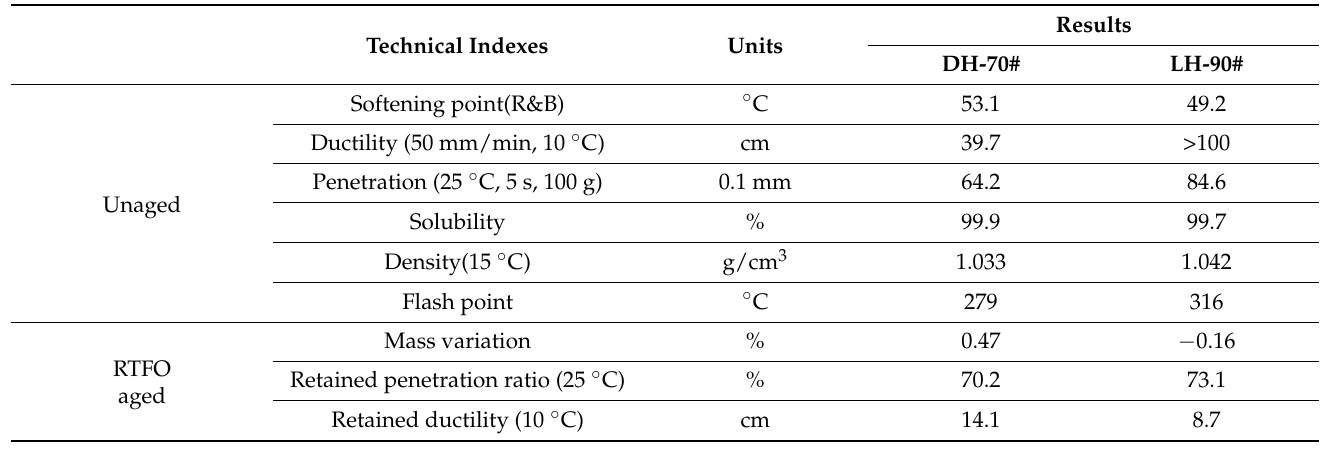
Table 1. Technical performance of asphalt.